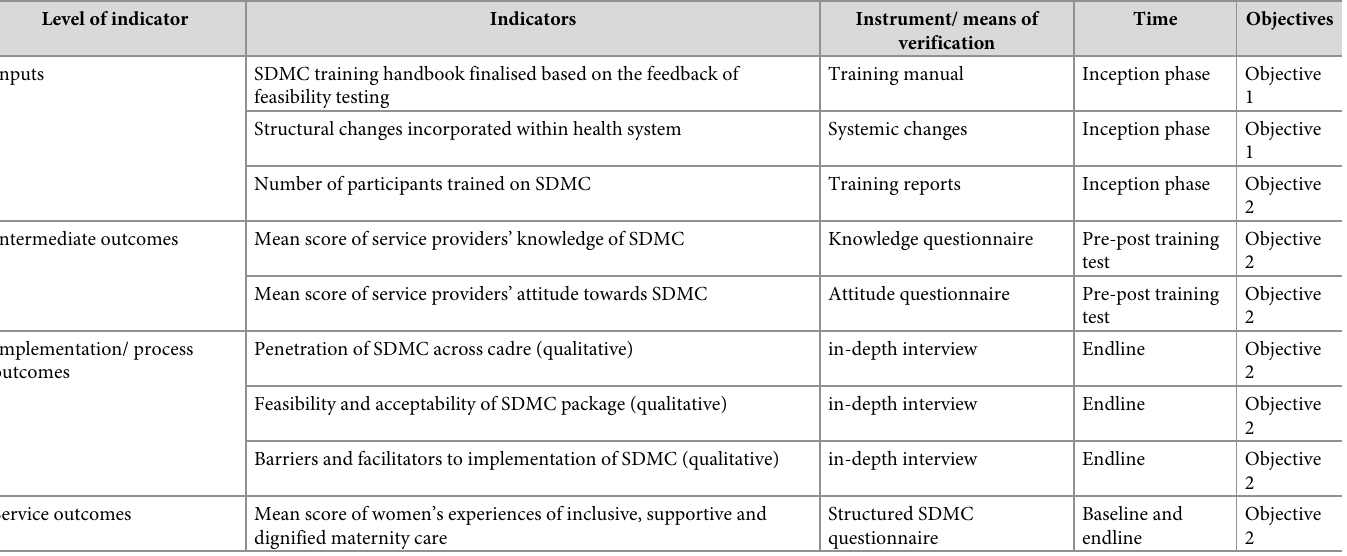
Table 1. List of input, process, intermediary and outcome